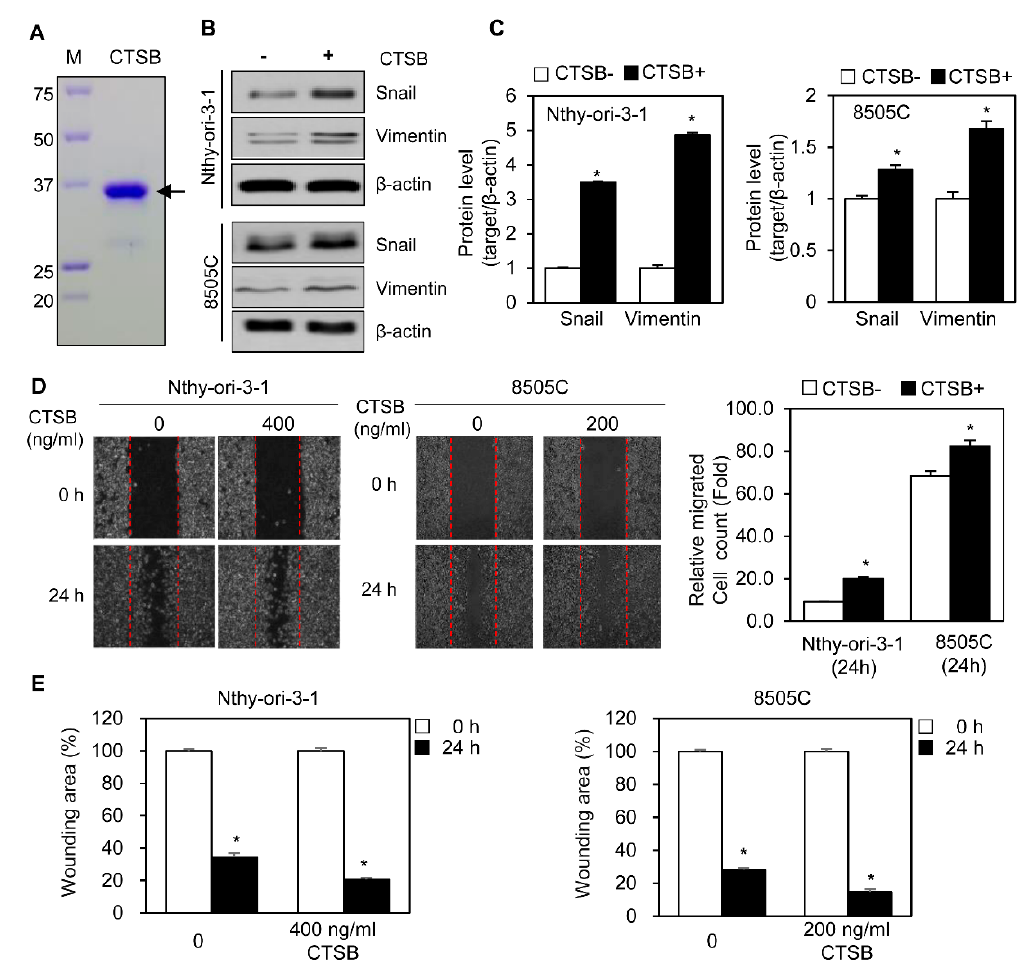
Figure 5. Treatment with recombinant CTSB induces cell migration in normal thyroid epithelial and thyroid cancer cell line. ( A ) Recombinant CTSB was produced in an Escherichia coli ( E. coli) system.